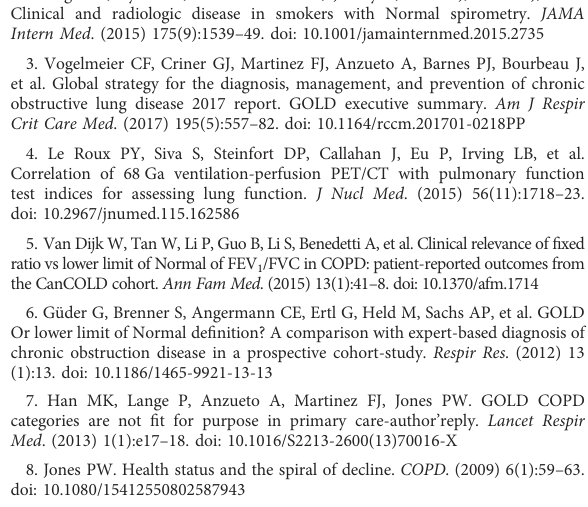
SUPPLEMENTARY FIGURE S1 Funnel plot about the publication bias for Correlation coef fi cients between CT measurements and air fl ow obstruction parameters SUPPLEMENTARY FIGURE S2 Trim- fi ll graph about the publication bias for Correlation coef fi cients between CT measurements and air fl ow obstruction parameters SUPPLEMENTARY TABLE S1 Electronic supplementary table 1 Literature search strategy. Last search on July 5, 2022 SUPPLEMENTARY TABLE S2 Characteristics of studies included in the systematic review SUPPLEMENTARY TABLE S3 Correlation coef fi cients between CT measurements and air fl ow obstruction parameters of pulmonary function test in the systematic review SUPPLEMENTARY TABLE S4 Characteristics of studies included in the meta-analysis SUPPLEMENTARY TABLE S5 Correlation coef fi cients between CT measurements and air fl ow obstruction parameters of pulmonary function test in the meta-analysis